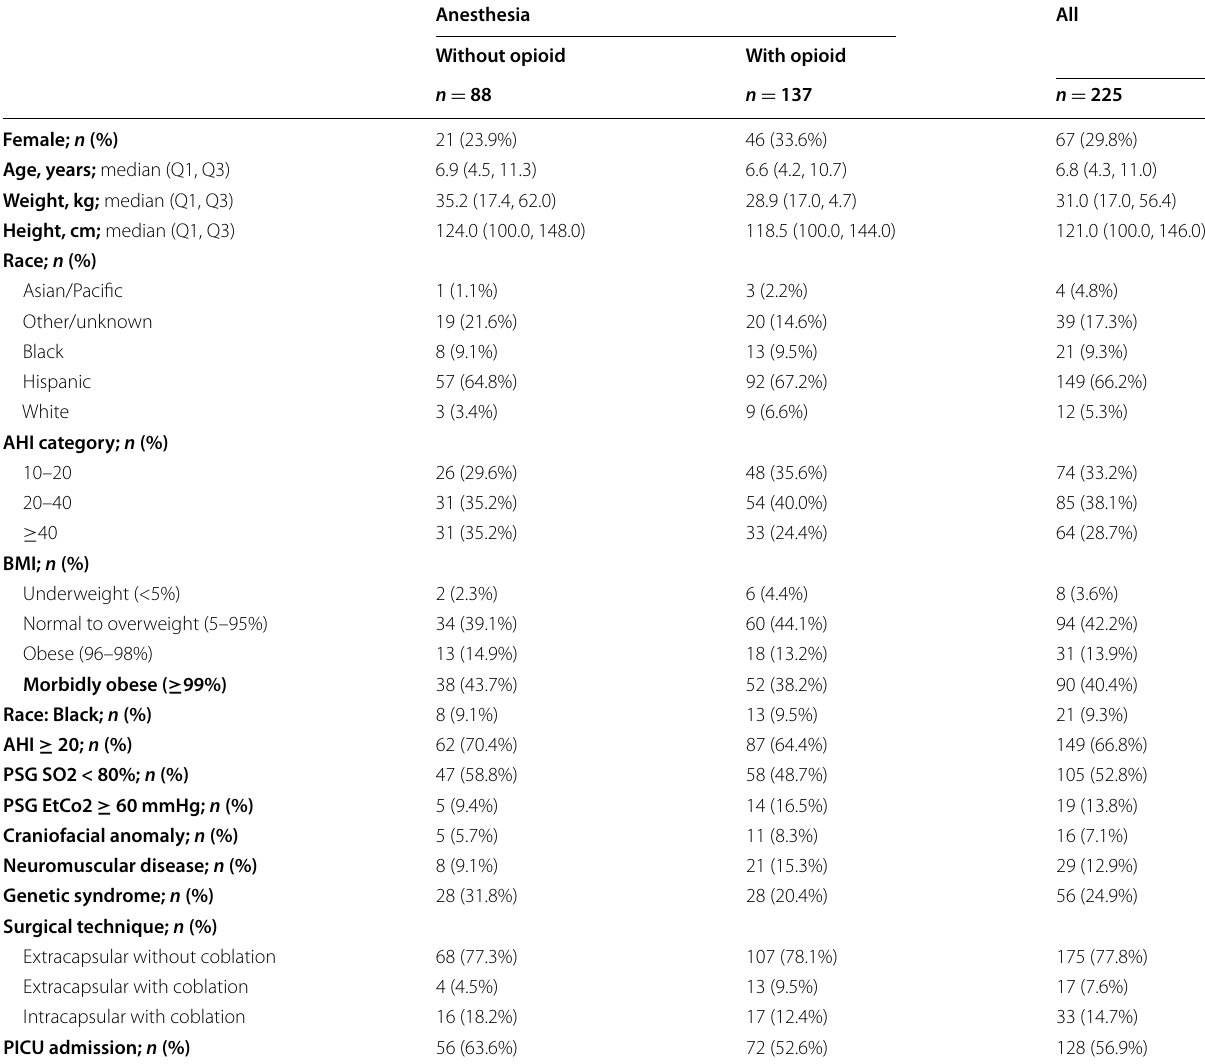
Table 1 Demographics of the population